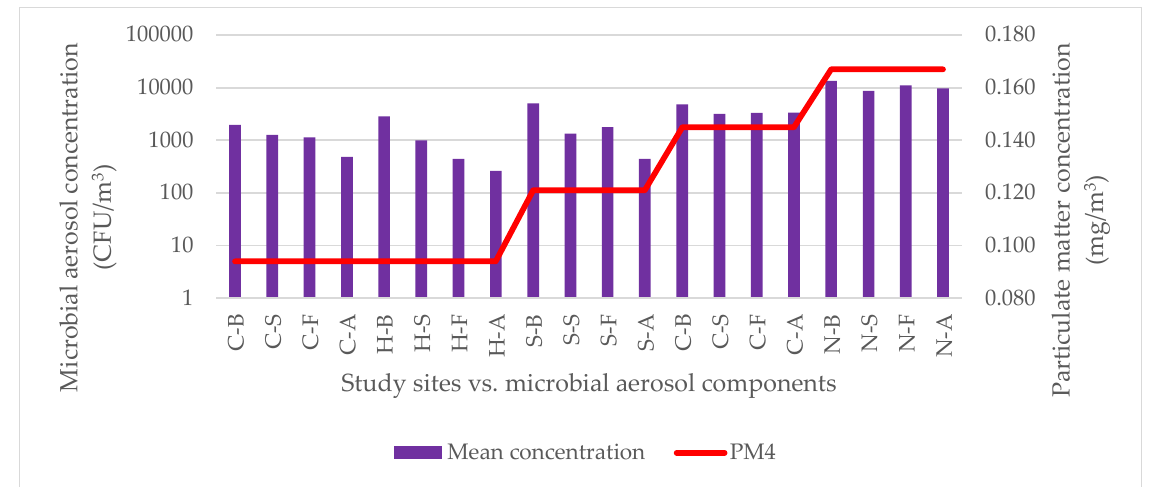
Figure 6. Mean concentration of respirable fraction of microbial aerosol (CFU/m 3 ) in the examined points compared with the concentration of PM 4 (mg/m 3 ). Explanation of symbols: C—classroom; H—sports hall; S—stable; C—cowshed; N—newborn calf shed; B—bacteria; F—fungi; S—staphylococcus; A—actinomycetes.